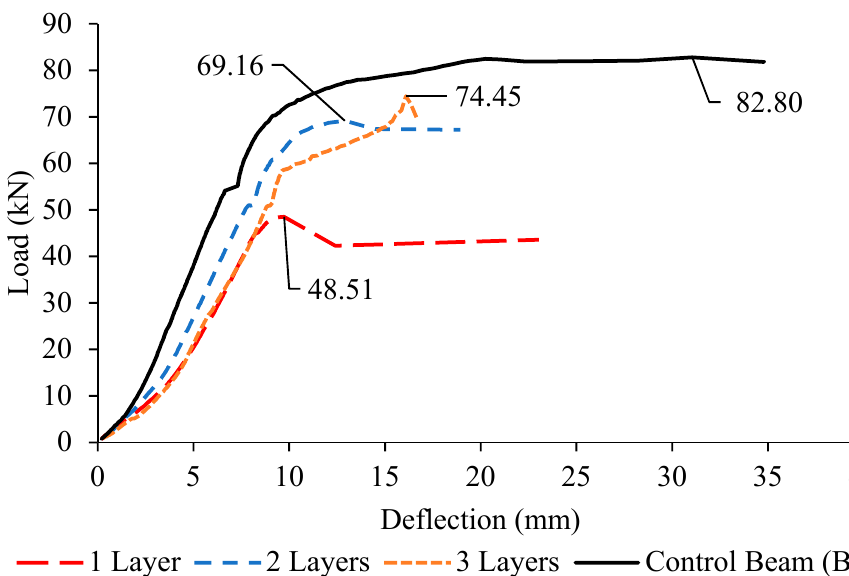
Figure 17. Load–deflection curves for Group 2 (B2a–B2c) deep beams and control beam.